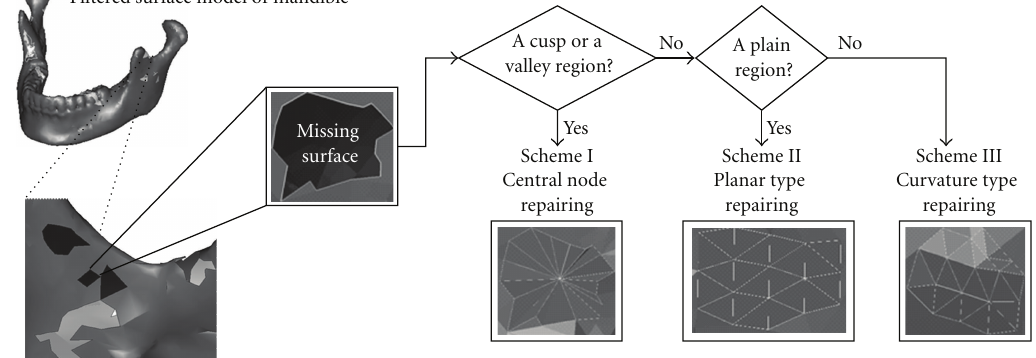
Figure 8: Surface repairing process involved in the tissue surface construction and processing step.